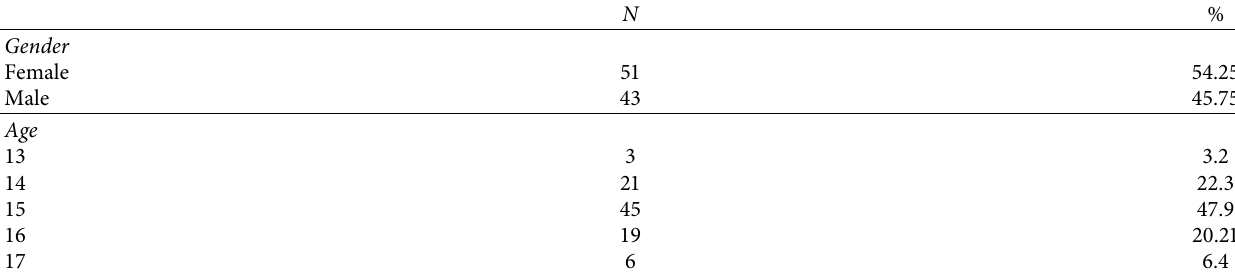
Table 1: Demographic characteristics (age and gender) ( N �